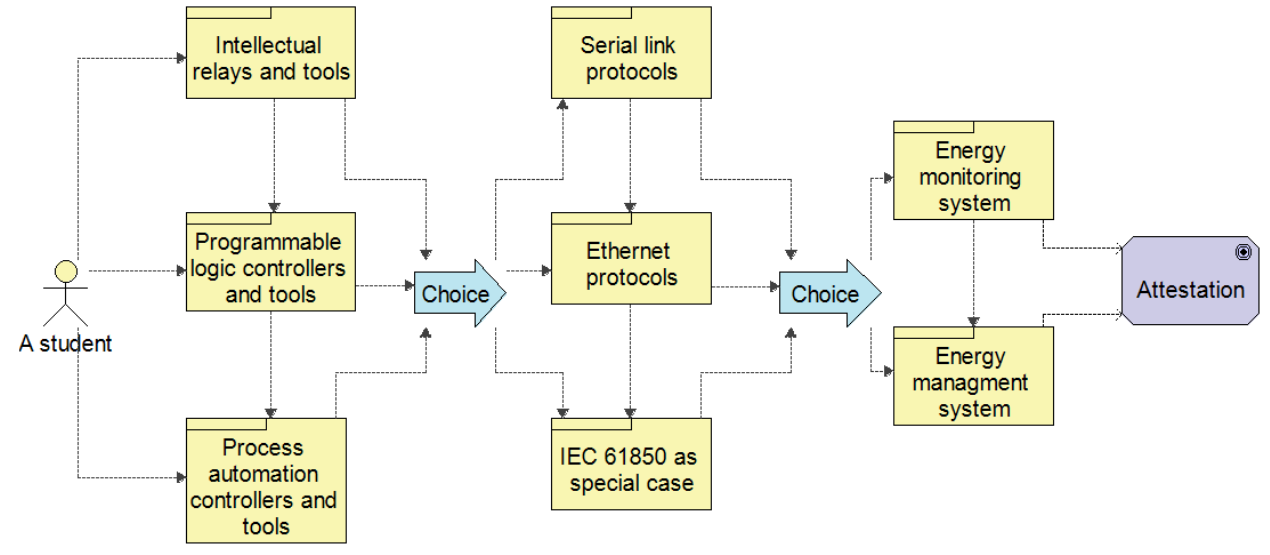
Figure 2 . Possible traces for studying